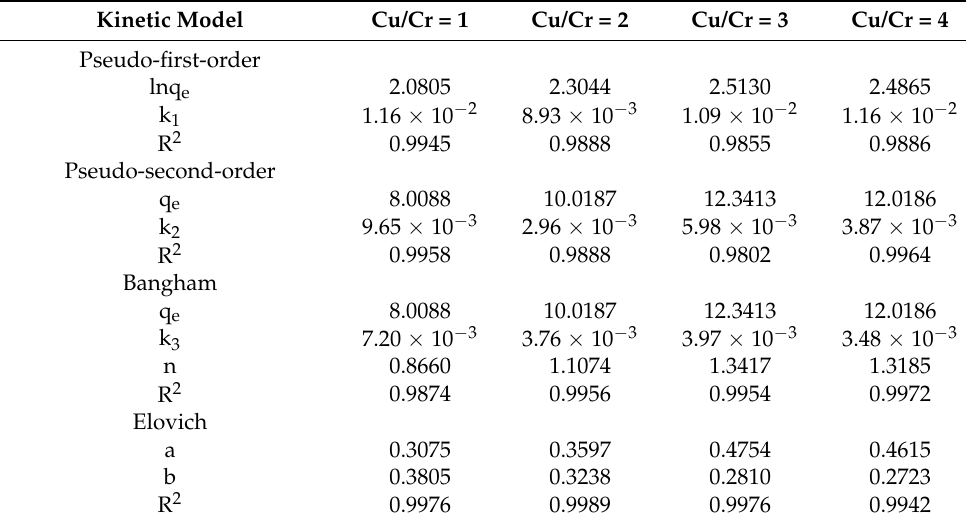
Table 4. Adsorption kinetics fitting parameters of NO adsorption on MWCNTs/Cu-Cr-TiO 2